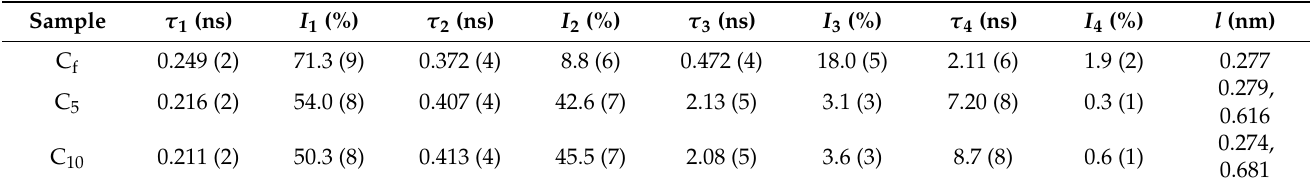
Table 3. Variation in microdefect results obtained from PALS spectra of the recovered TiO 2 - MMT 60 /PCN 40 @Pd 0 nanocomposites with four-lifetime fitting. Experimental errors are provided in parentheses in term of uncertainty of the last meaningful